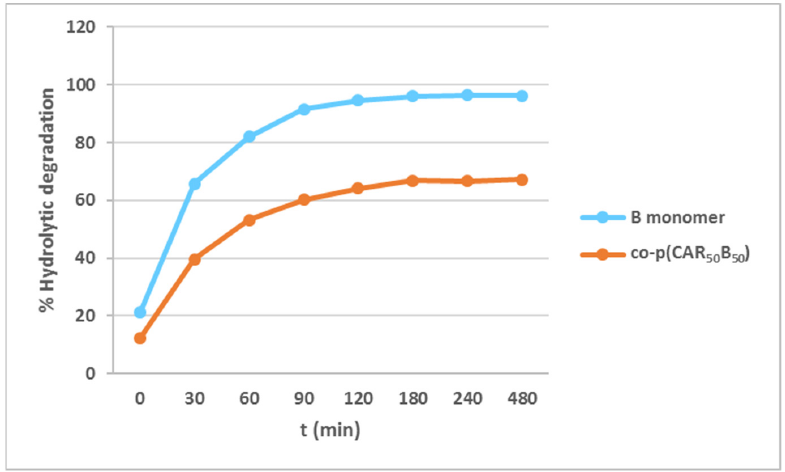
Figure 5. Evolution of hydrolytic degradation of the B monomer and co ‐ p(CAR 50 B 50 ) over time.